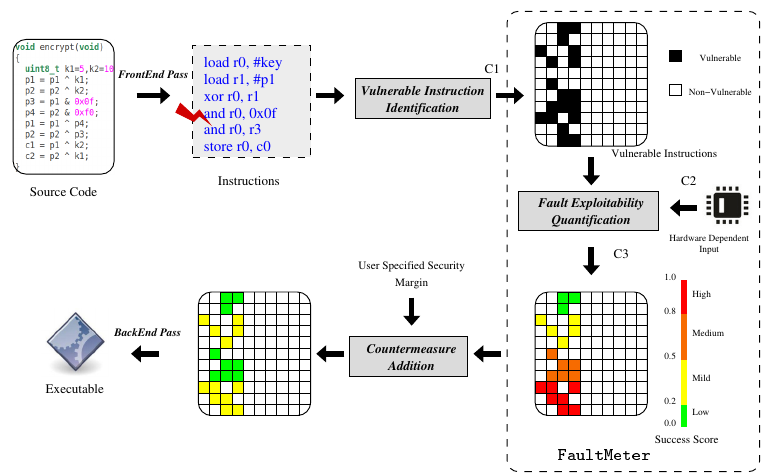
Figure 1: The FaultMeter framework, to quantify the vulnerability of block cipher implementations. It has two main modules. The Vulnerable Instruction Identification Module detects vulnerable instructions, while the Fault Exploitability Quantification module quantifies the exploitability. The figure also shows an application of FaultMeter to automatically insert countermeasures into the implementation. The countermeasures are tuned to meet the user’s security